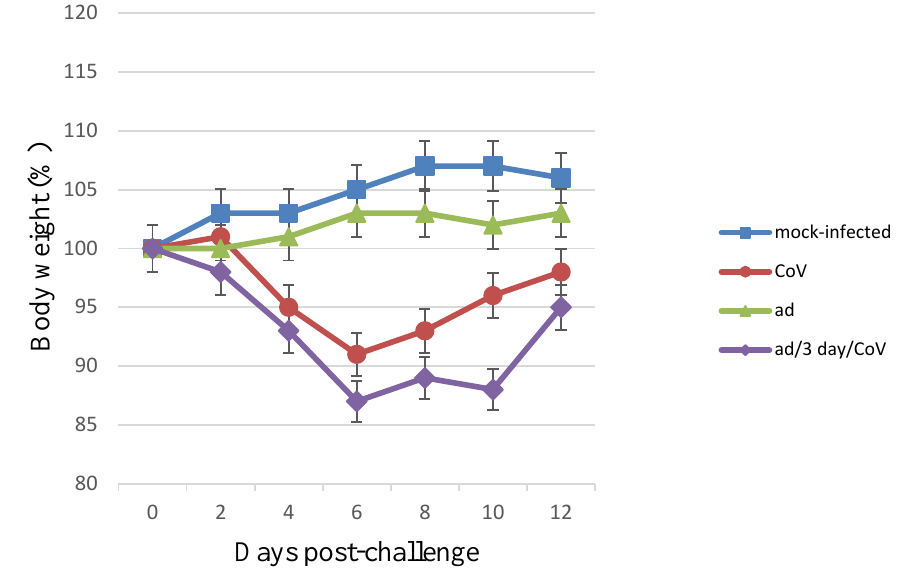
Figure 1. Body weight changes in monoinfected and coinfected with HAdV-5 and SARS-CoV-2 Syrian hamsters. “CoV (SARS-CoV-2)”—on Day 0, the Syrian hamsters were intranasally challenged with SARS-CoV-2 (10 5 TCID 50 ); “ad (HAdV-5)/3-days/CoV”—on Day 0, the preinfected (3 days earlier) with HAdV-5 (10 6 TCID 50 ) hamsters were intranasally challenged with SARS-CoV-2 (10 5 TCID 50 ); “ad”—on Day 0, the Syrian hamsters were intranasally challenged with HAdV-5 (10 6 TCID 50 ); “mock-infected”—on Day 0, the hamsters were intranasally inoculated wits PBS. n = 9 at 0 dpi to 4 dpi; n = 6 at 5 dpi to 6 dpi as 3 animals were sacrificed; n = 3 at 7 dpi to 12 dpi as 3 animals were sacrificed. The values represent the means ± SDs of individual animals. Student’s t -test was used for two-group comparisons, p < 0.05.